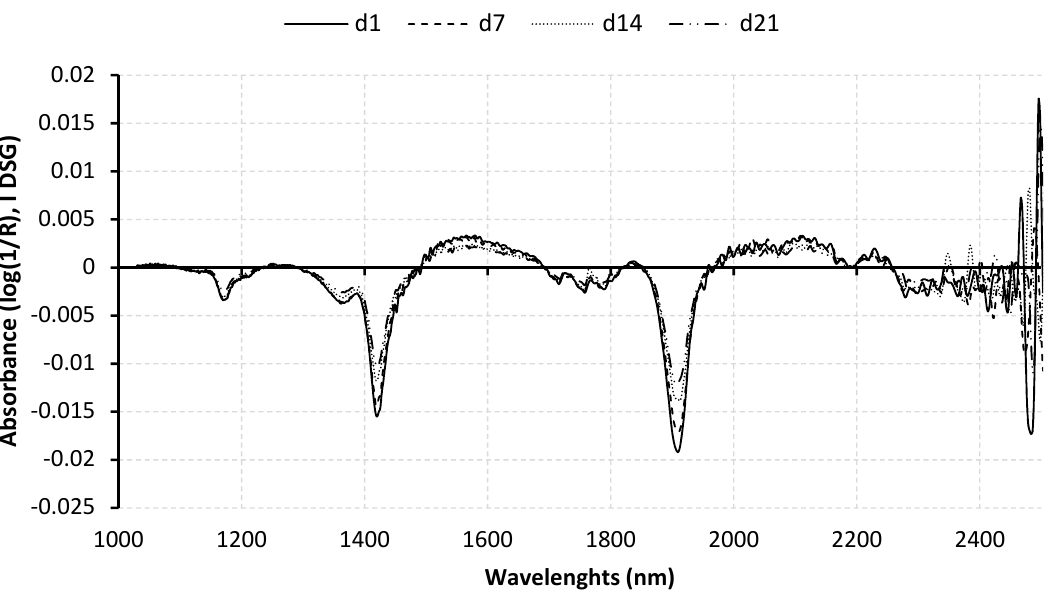
Figure 1. Average first derivatives Savitzky–Golay (I DGS) pre-treatment spectra (log(1/R)) of longissimus lumborum samples aged for 1 (d1), 7 (d7), 14 (d14) and 21 (d21) days.